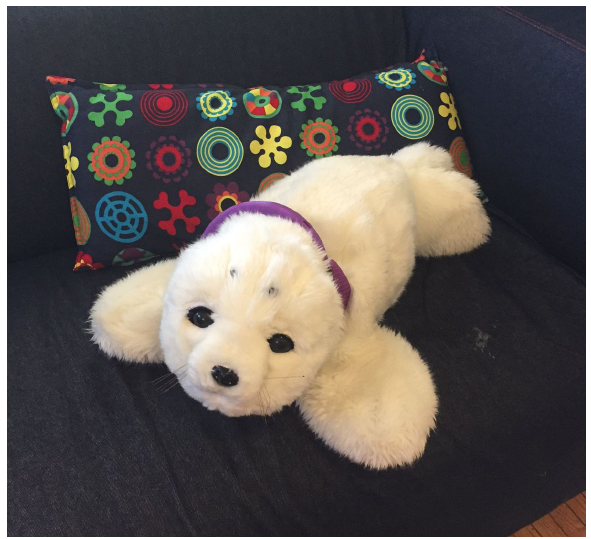
Figure 1: Paro: a socially assistive, seal-like